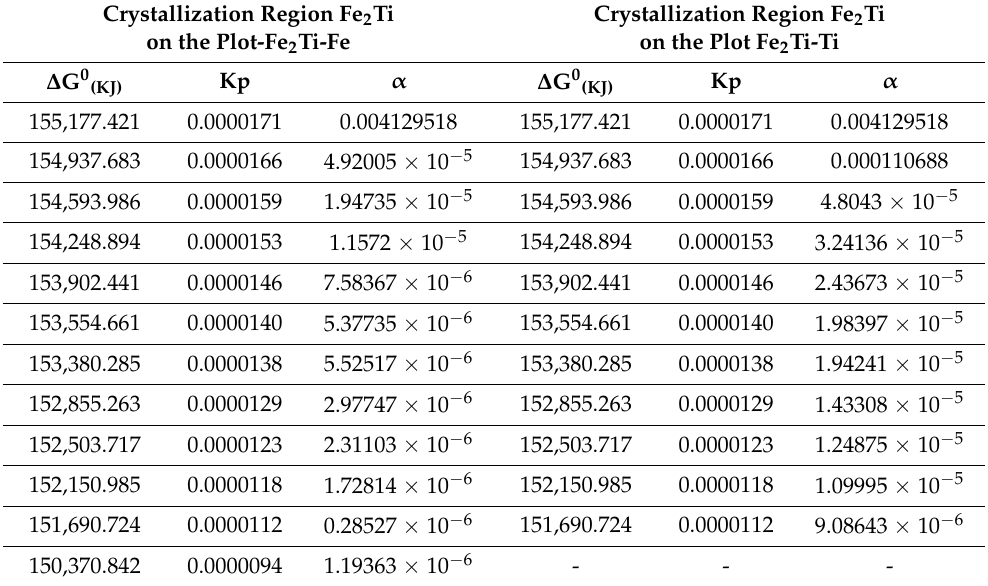
Crystallization Region Fe 2 Ti on the Plot Fe 2 Ti-Ti